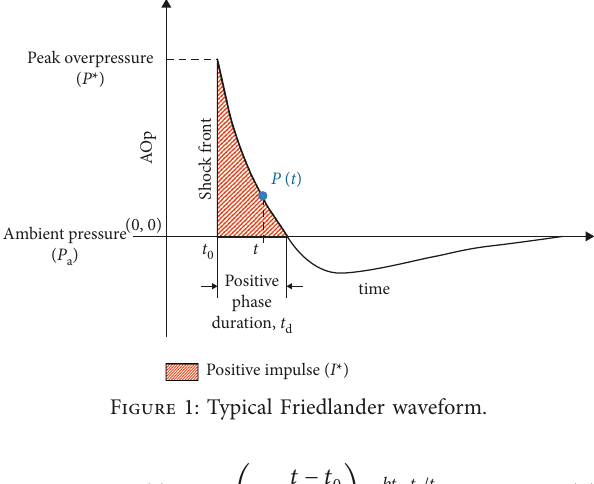
Figure 1: Typical Friedlander